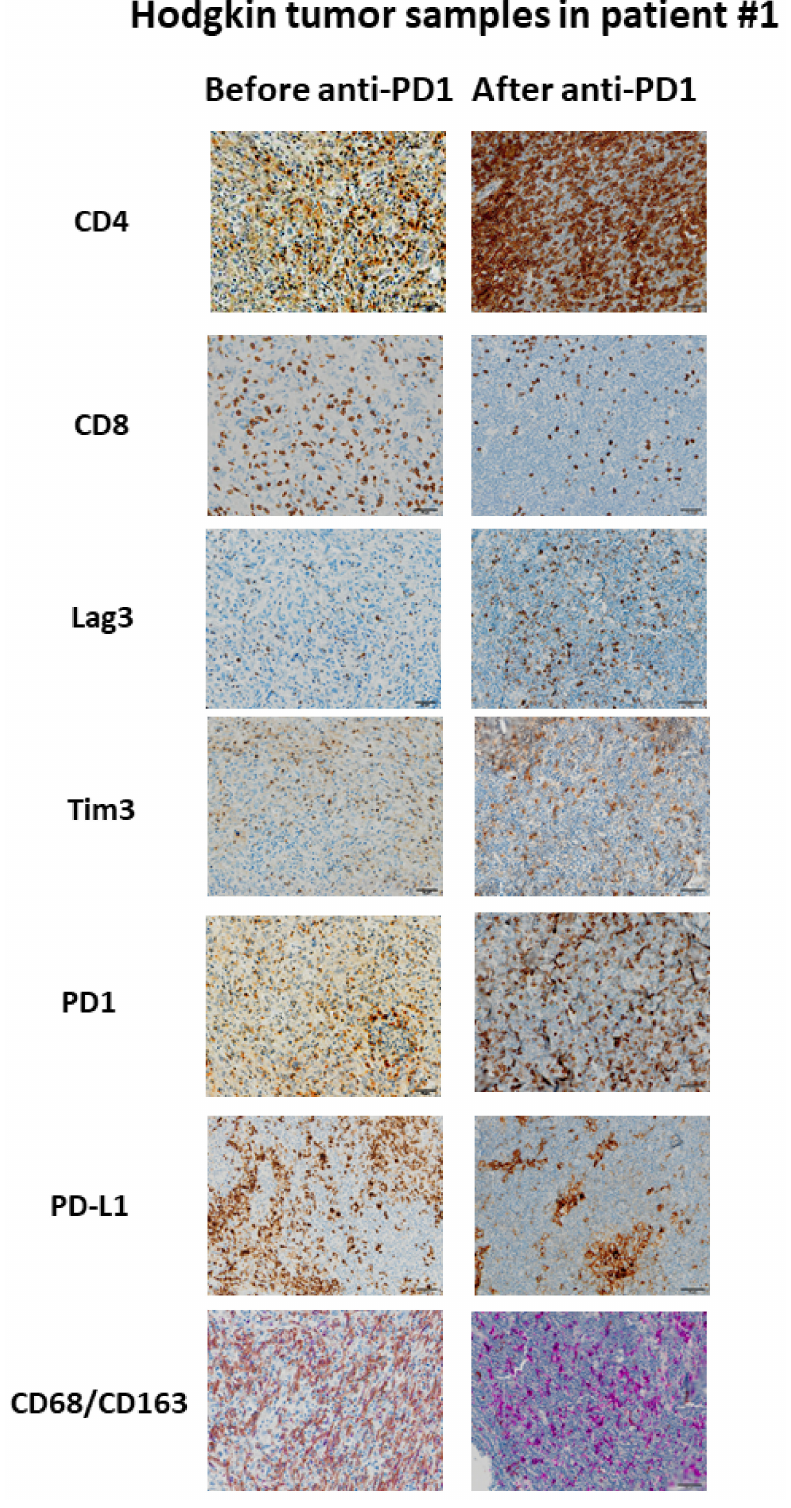
Figure 3. Example of immunological changes before and after anti-PD-1 on paired tumor biopsies (paired biopsy analysis, part A study). Pictures were captured from tumor samples of paired tumor biopsy before and after anti-PD-1 immunotherapy from patient #1, with immunohistochemistry staining for CD4, CD8, LAG-3, Tim3, PD-1, PD-L1, CD68/CD163. The scale bar on each image (lower right corner) is equal to 50 µ